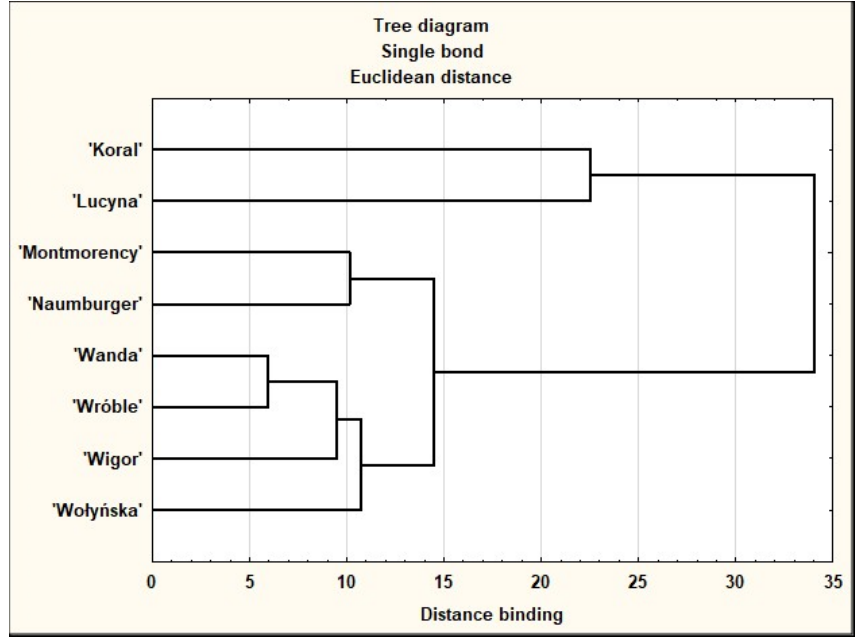
Figure 2. Dendrogram of eight sour cherry cultivars based on numerical data for bioactive compounds with antioxidative properties in the studied oils, including derivatives of tocopherols ( α , β , γ , δ ) and tocotrienols ( α , γ ), total tocochromanol, total carotenoid, and total polyphenol content, as well as